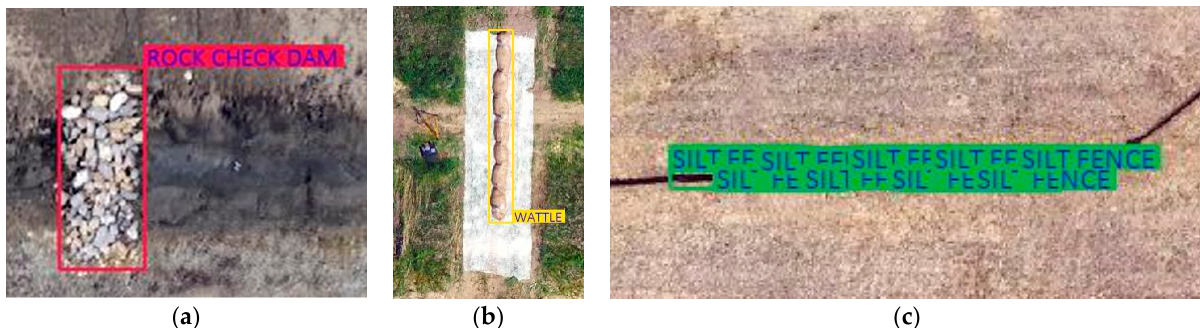
Figure 4. Annotation of temporary E&SC practices: ( a ) rock check dam; ( b ) wattle ditch check; ( c ) silt fence sediment barriers.